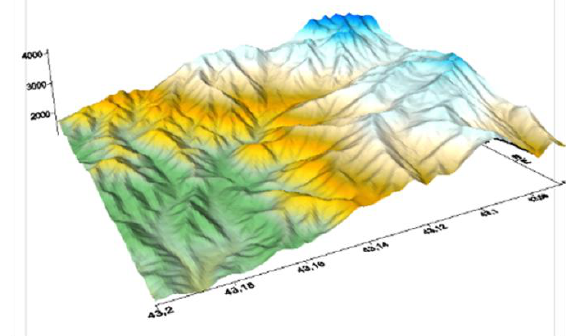
Figure 1. Created in the program «Surfer» a 3D terrain